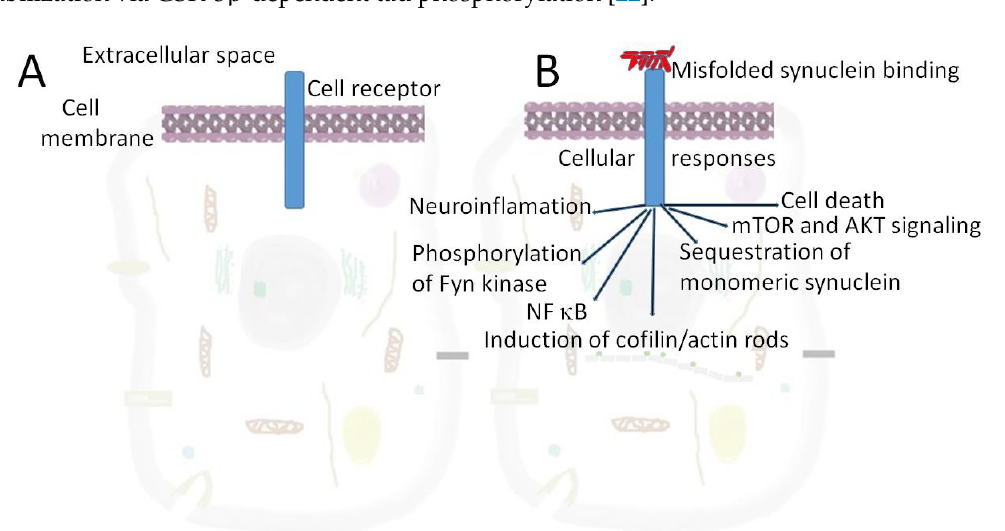
Figure 1. The effect of extracellular α -synuclein binding to cellular receptor on neuronal or glial cells. Various proteins may fulfill the role of such receptors, including PrPC, LAG3, neurexin 1 α [17], TLR2 [23], mGluR5 [12], Fc gamma receptor IIb [24] (Table 1) and others. Gangliosides in the lipid rafts can also act as receptors for extracellular α -synuclein [25]. A –a cell in the absence of extracellular α -synuclein, B –cellular response on α -synuclein